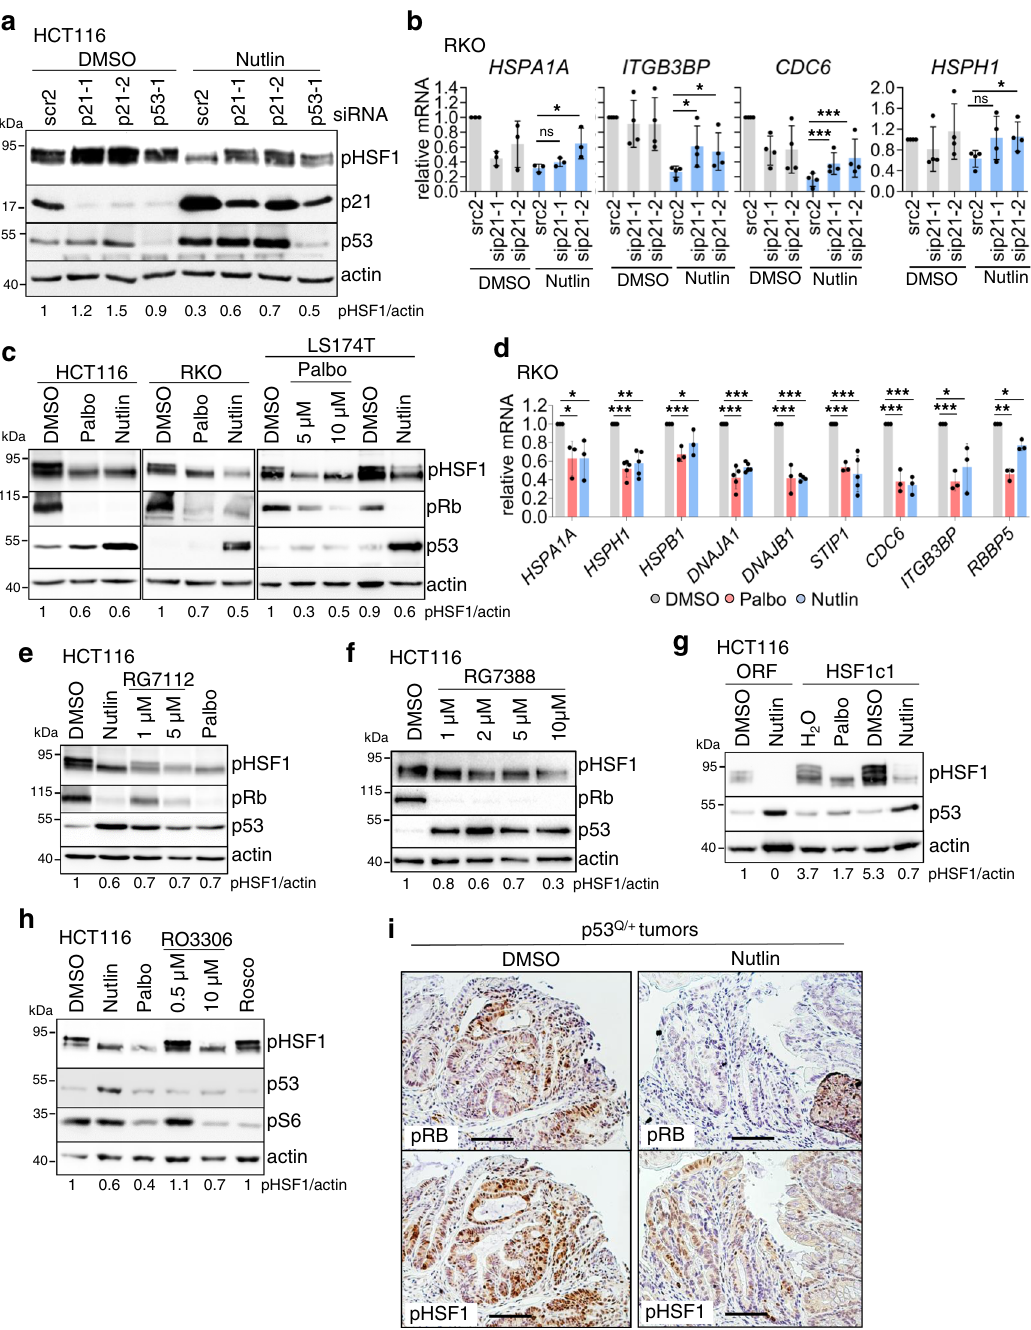
Fig. 4 p53 suppresses HSF1 activity via cyclin-dependent kinase inhibitor CDKN1A /p21 in human CRC cells. a p21 silencing attenuates Nutlin-induced HSF1 suppression. Forty-eight hours after HCT116 cells were transfected with siRNAs against p21 and p53 or scrambled control siRNA, cells were treated with 10 µ M Nutlin /DMSO for 24 h. b Rescue of p53-induced HSF1 target gene suppression by p21 depletion in RKO cells treated as in a . c WTp53- harboring CRC cell lines were treated with DMSO, 10 µ M Palbociclib (Palbo), or 10 µ M Nutlin for 24 h. Cell cycle inhibition was con fi rmed by Rb de(hypo) phosphorylation. pRb phospho-Rb. d HSF1 target gene repression after direct cell cycle inhibition. RKO cells were treated with 10 µ M Palbociclib (CDK4/6 inhibitor), 10 µ M Nutlin, or DMSO for 24 h. e , f Cell cycle inhibition by p53 inactivates HSF1 activity. HCT116 cells were treated with DMSO, 10 µ M Nutlin, 10 µ M Palbociclib, RG7112 ( e ) or RG7388/Idasanutlin ( f ) as indicated for 24 h. g Cell cycle inhibition prevents pSer326-HSF1 activation in stably HSF1- overexpressing HCT116 cells. HSF1c1 or empty vector clone (ORF) were treated with DMSO, H 2 O, 10 µ M Nutlin, or 10 µ M Palbociclib for 24 h. h CDK4/6 inhibition causes HSF1 suppression. HCT116 cells were treated with DMSO, 10 µ M Nutlin, 10 µ M Palbociclib, 0.5 and 10 µ M RO3306, and 20 µ M Roscovitine (Rosco) for 24 h. i Representative immunohistochemistry of serial sections for pRB and pHSF1 from p53 Q/ + tumors treated with DMSO or Nutlin as in Fig. 2a ( n = 6 tumors each). Scale bars, 100 μ m. b , d qRT-PCR, normalized to RPLP0 mRNA. Relative values given in [ratio (2 − ddCT )]. Mean ± SD of ≥ 2 independent experiments, at least one with a technical replicate. Student ’ s t test, two-sided. * p ≤ 0.05, ** p ≤ 0.01, *** p ≤ 0.001; ns not signi fi cant. a , c , e – h Immunoblot analyses. Actin, loading control. pHSF1/actin, pHSF1 densitometry normalized to loading control. Source data are provided as Source data fi